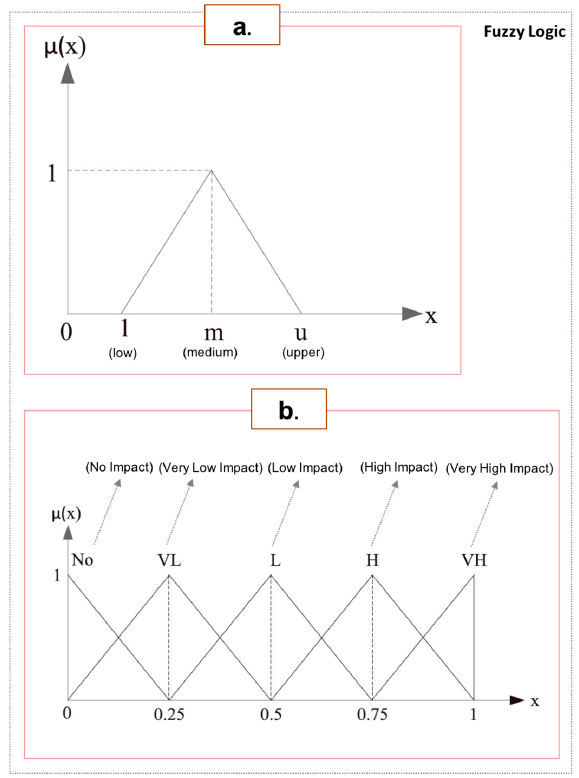
Figure 4. The fuzzy logic diagrams: ( a ) Triangular Fuzzy Number (TFN) diagram and ( b ) Fuzzy memberships and ratings function diagram [37,38].